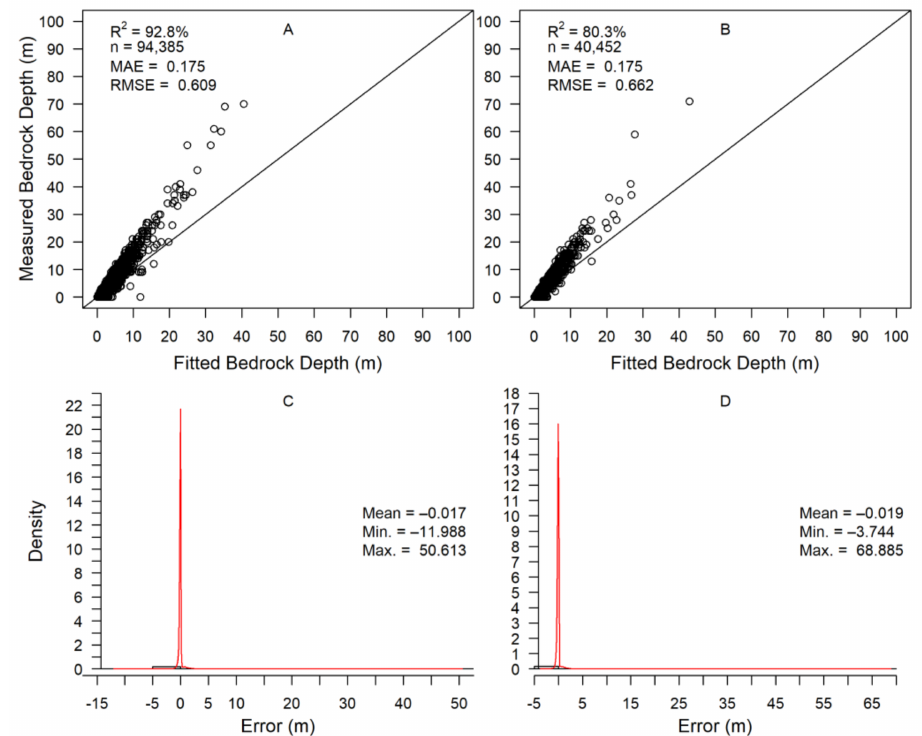
Figure 7. Actual vs. fitted model results for the training and validation subsets (( A , B ), respectively) including 95% confidence limits, and histograms displaying densities of residual errors for DTB model on training and validation subsets (( C , D ), respectively).